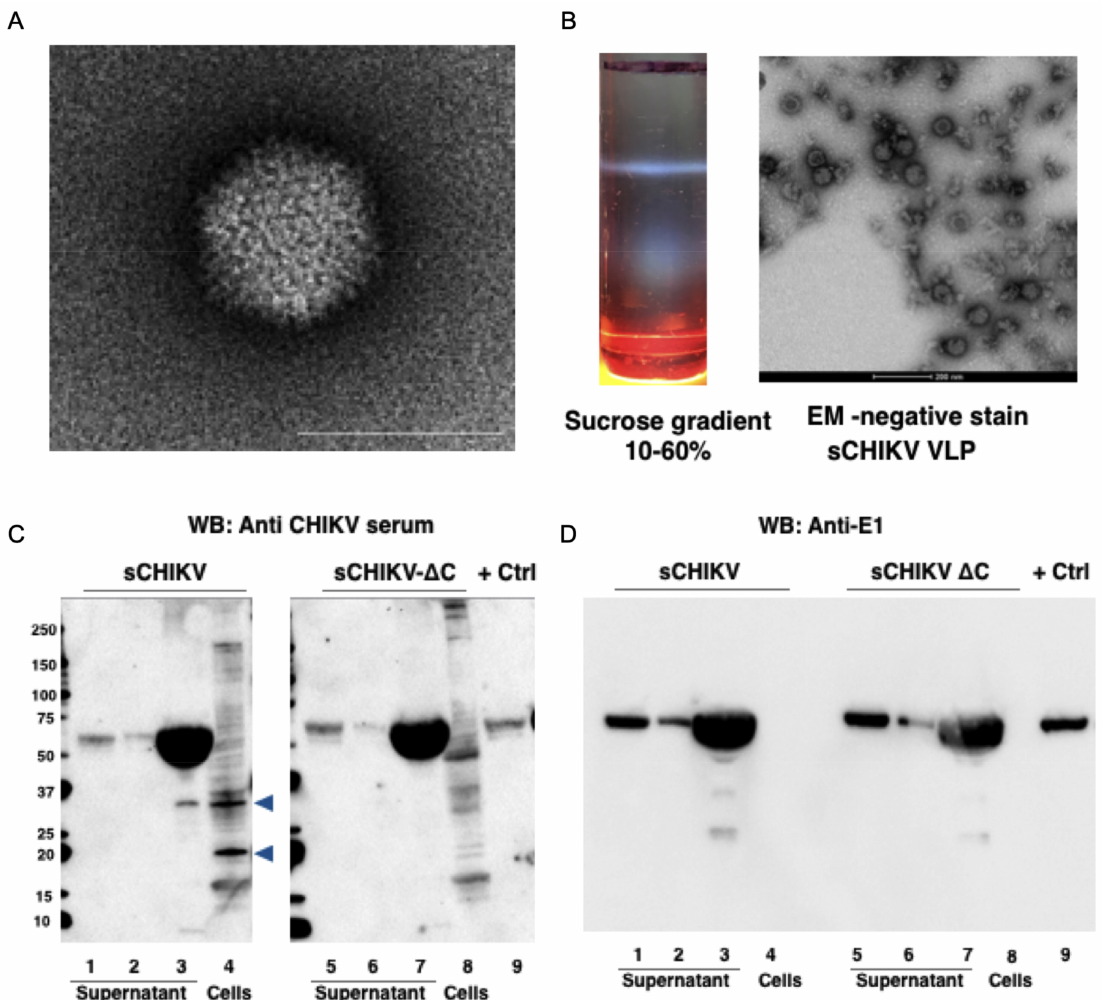
Figure 3. Characterisation of recombinant chimpanzee adenoviral (ChAdOx1)-based vaccines for CHIKV. ( A ) Electron microscopy from a ChAdOx1 sCHIKV vaccine preparation, white line is 100 nm. ( B ) Sucrose gradient purification from the supernatants after expression of CHIKV structural cassette (left). Transmission electron microscopy showing CHIKVLP formation from the isolated gradient band, the white line is 200 nm. ( C,D ) Transduction of ChAdOx1 sCHIKV and ChAdOx1 sCHIKV ∆ C in Vero cells; supernatant and cellular extracts were probed against anti-CHIKV serum ( C ) or anti-E1 monoclonal antibody ( D ). Blue arrowhead in sCHIKV blot shows bands that were not present in sCHIKV ∆